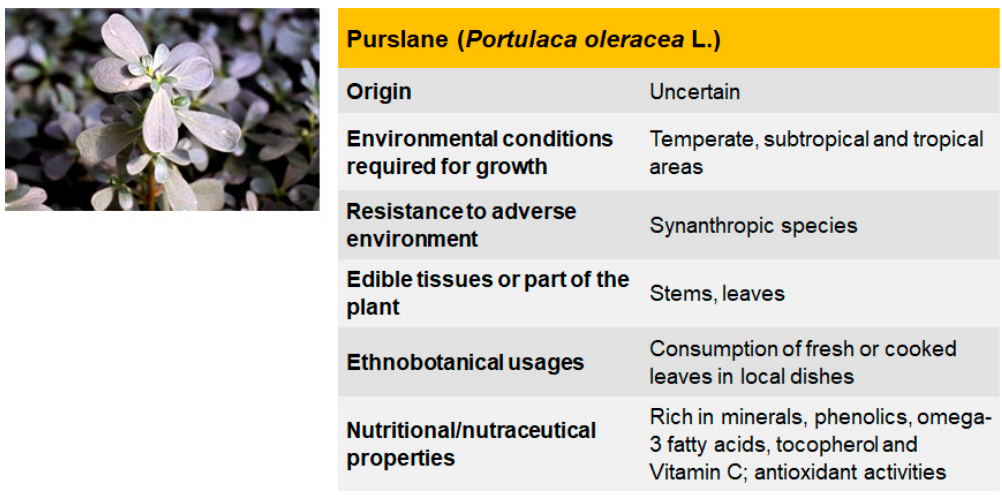
Figure 4. Scheme of the main features of P. oleracea (Source photo: biodiversitàpuglia.it [35]). Table 4. Some examples of polyphenol, vitamin C, tocopherol, and fatty acid content in purslane.